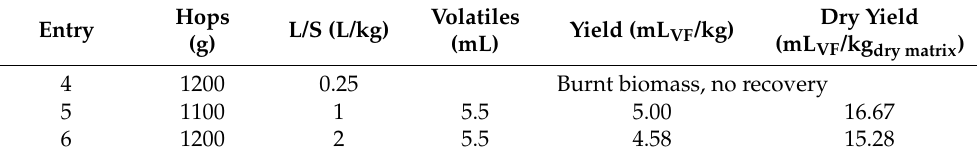
Table 4. MAHD, moistening screening. Extraction material: fresh hops (FH).